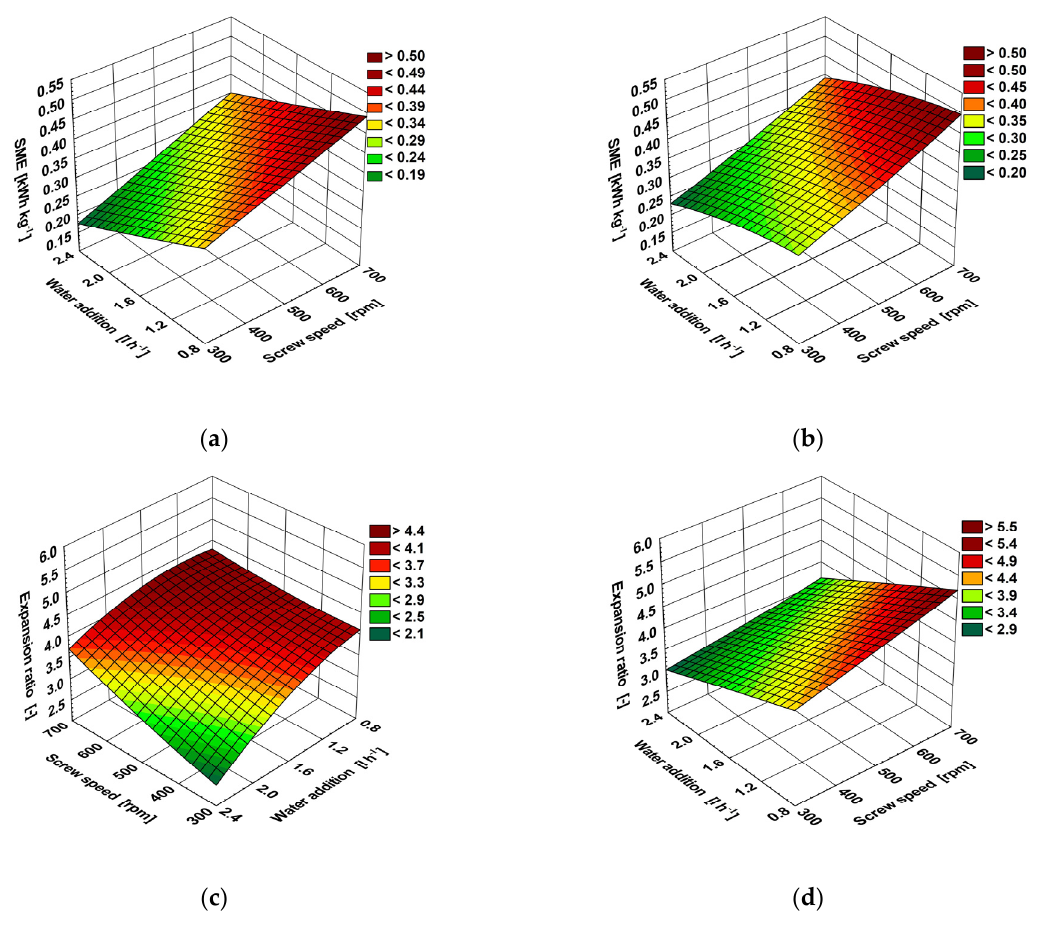
Figure 1. Effect of various extrusion parameters on SME and expansion ratio of extruded red beans ( a , c ) and white beans ( b , d ).